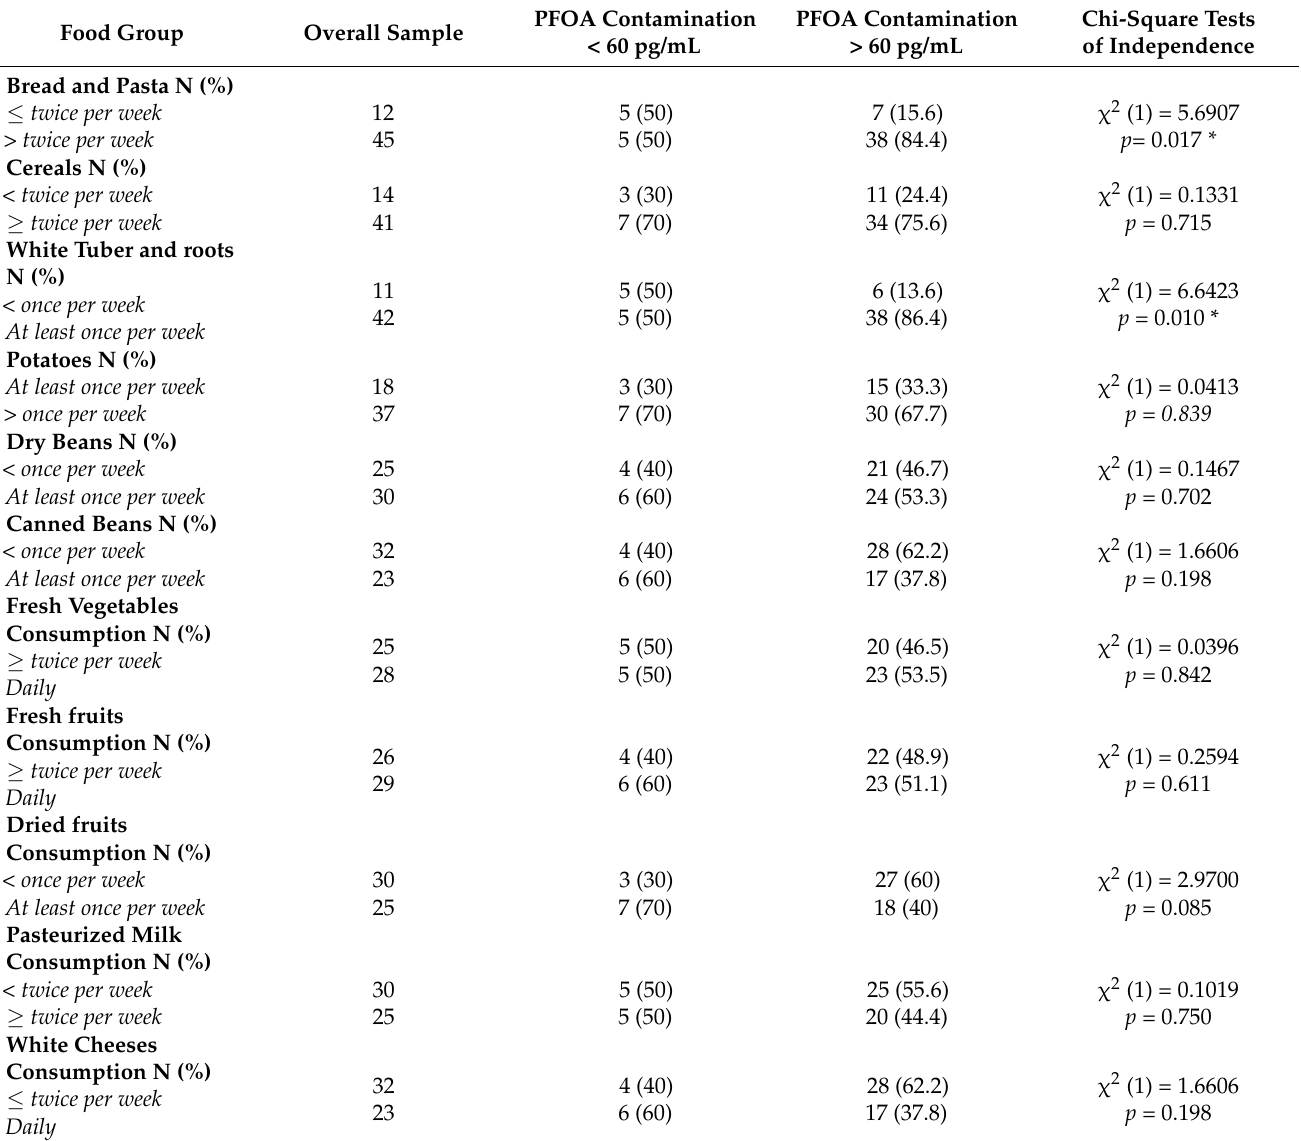
Table 3. Crosstabulation of food groups and PFOA contamination in Human